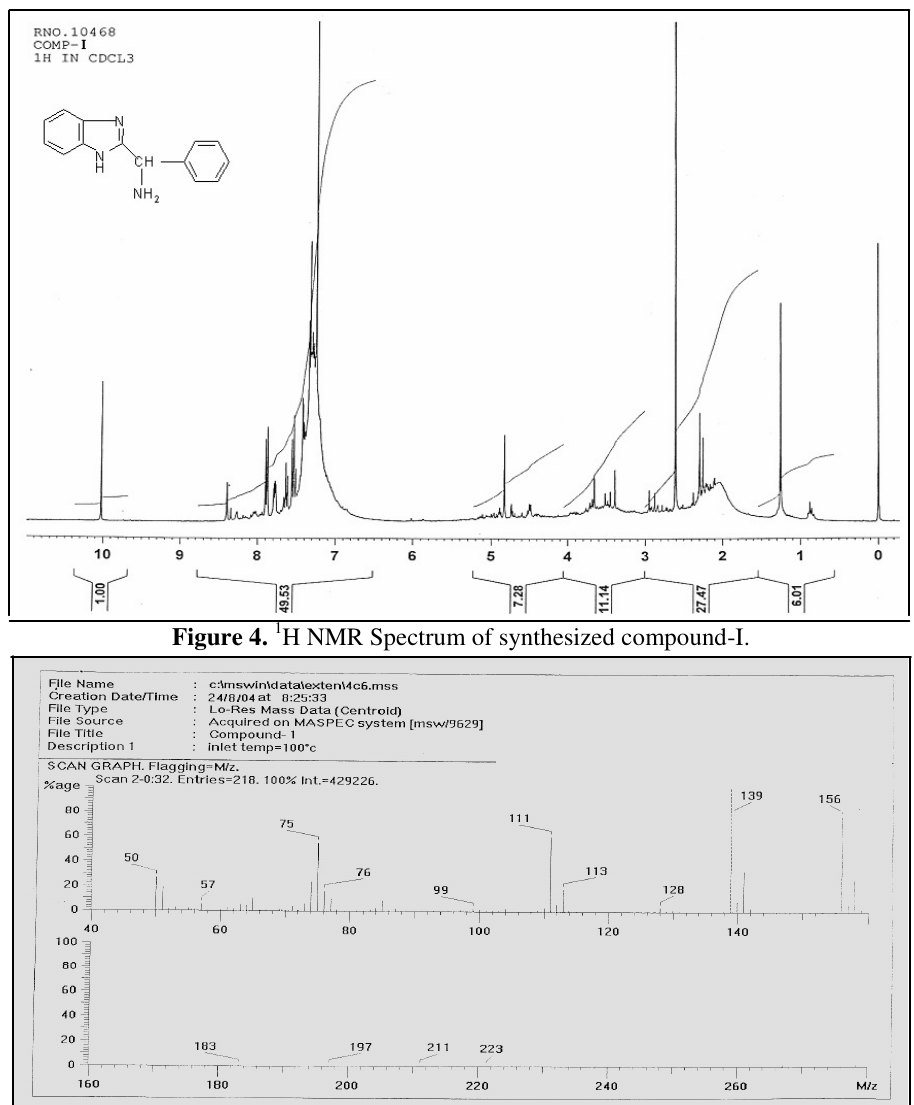
Figure 5. Mass spectrum of synthesized